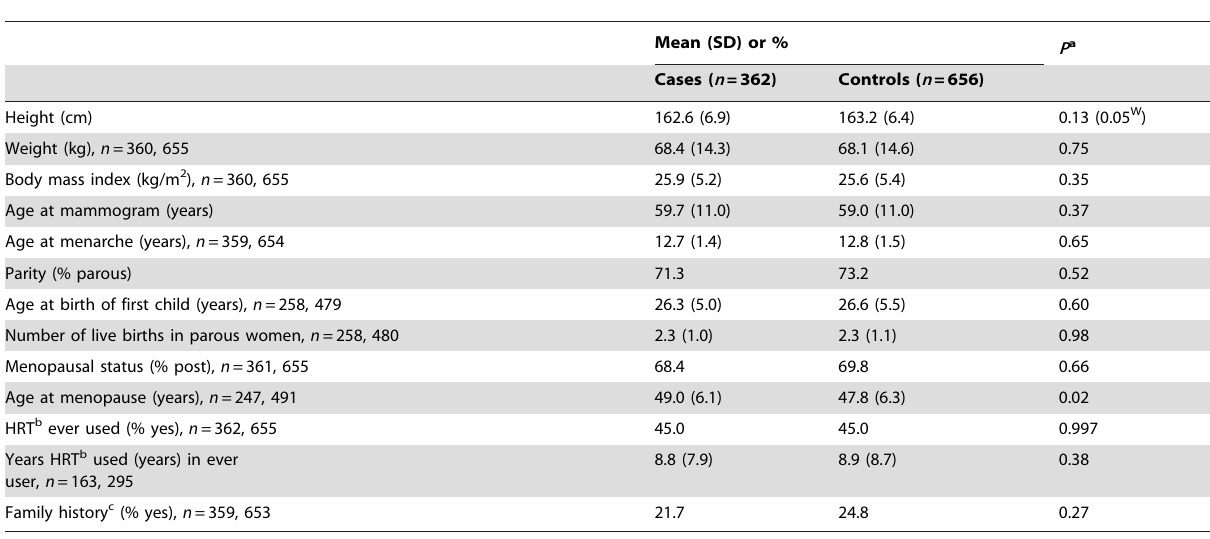
Table 1. Risk factors by case-control